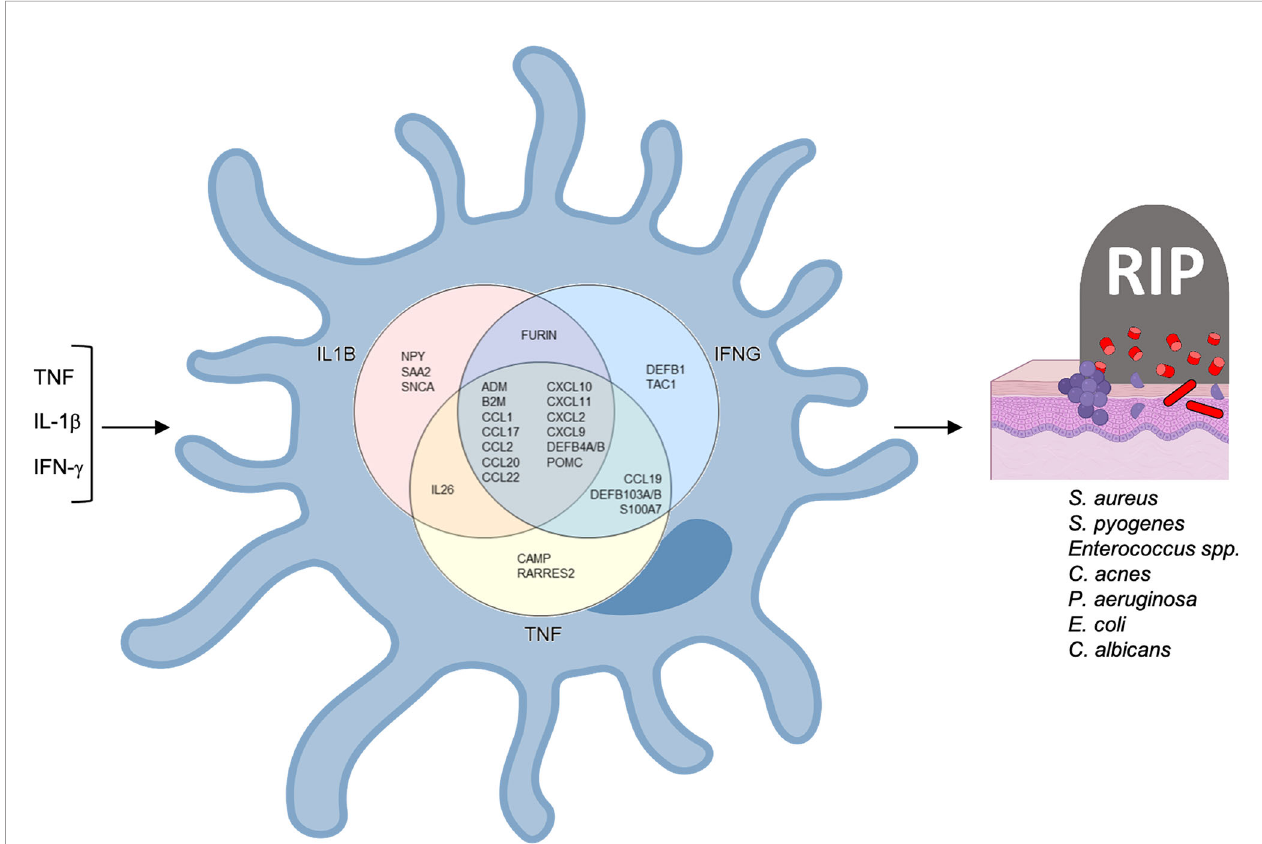
FIGURE 5 | Antimicrobial network induced by TNF, IFNG and IL1B in LCs. TNF and IFNG were each identi fi ed as upstream regulators of 19 antimicrobial genes and IL1B as the upstream regulator of 18 antimicrobial genes.